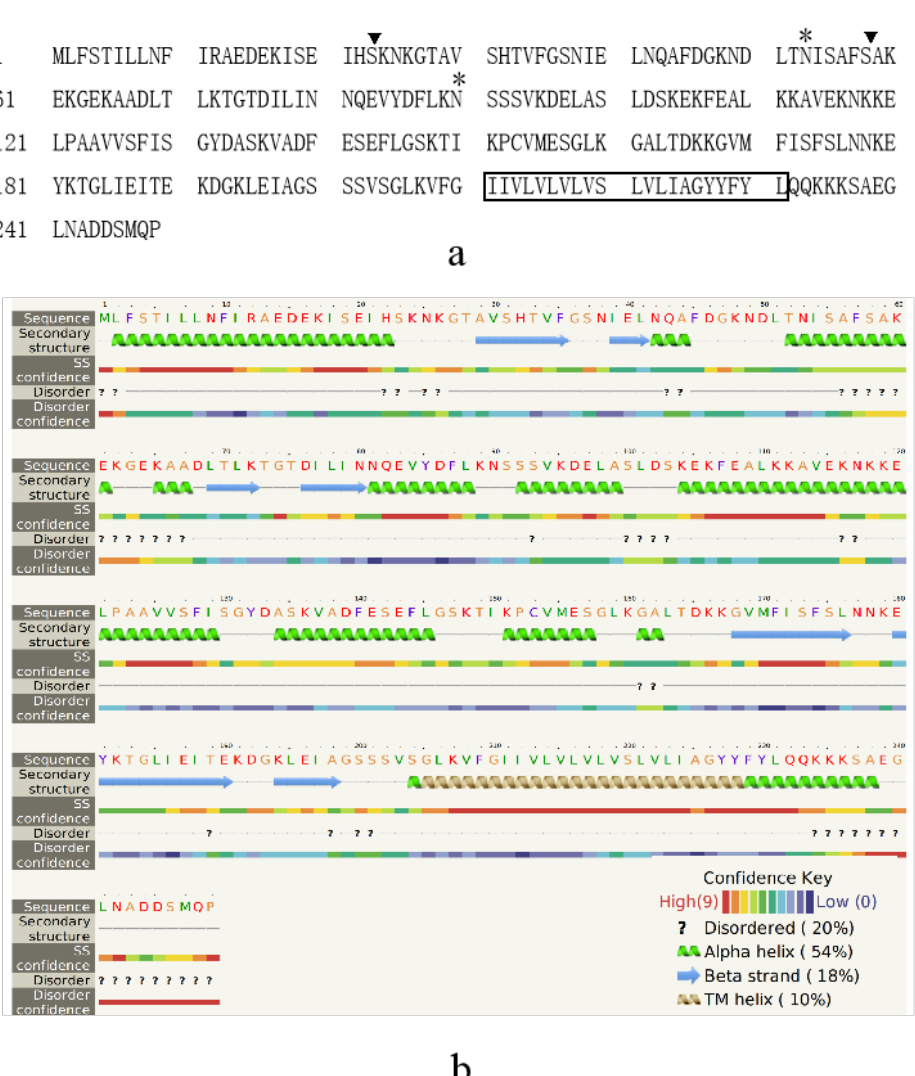
Figure 6. Amino acid sequence analysis and 2D structure prediction of EhSWP3. ( a ) Predicted post-translational modification sites. The transmembrane domain (TM) was boxed. N- and O-glycosylation sites were marked with “*” and “ ▼ ”, respectively. ( b ) The 2D structure of EhSWP3. The transmembrane domain (aa 209–231) was localized in the brown TM helix.